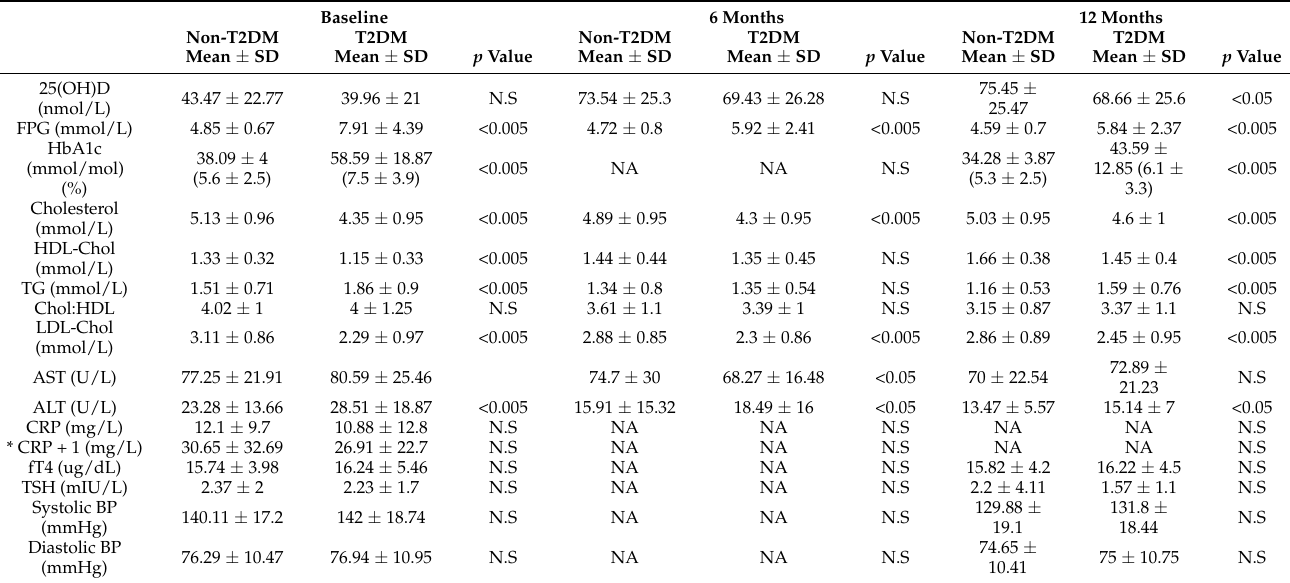
Table 2. Comparison between biological characteristics of T2DM and non-T2DM patients at baseline, 6 and 12 months after SG.